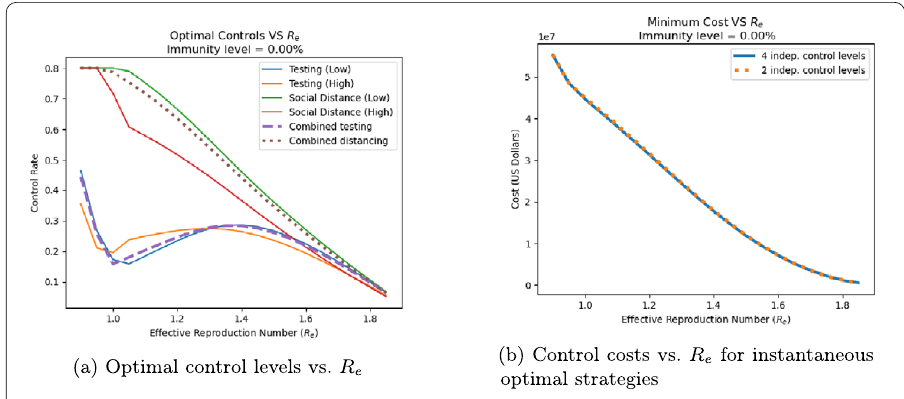
Figure 10 Optimal control levels ( a ) an associated control costs ( b ) as a function of population’s current R e value for populations with 0% immunity. Solid lines correspond to strategies in which both controls can be applied at different levels on the low-risk and high-risk population subgroups, while dashed lines are for strategies in which the same control levels are applied to both subgroups